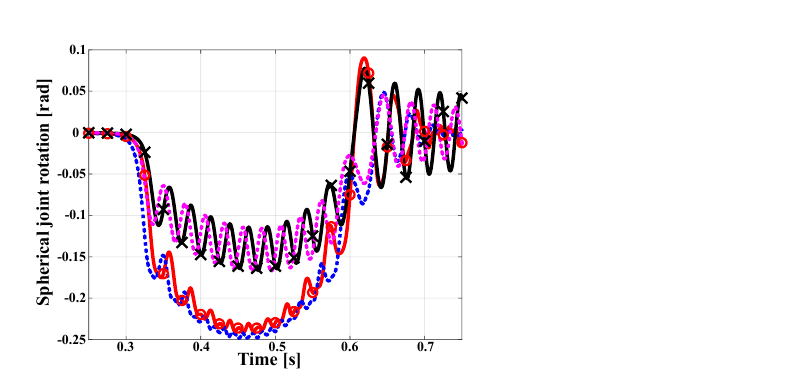
Figure 20. Rotation components for the spherical joint: φ 1 ( ◦ ), and φ 3 ( × ): plate model, solid line; beam model, dashed